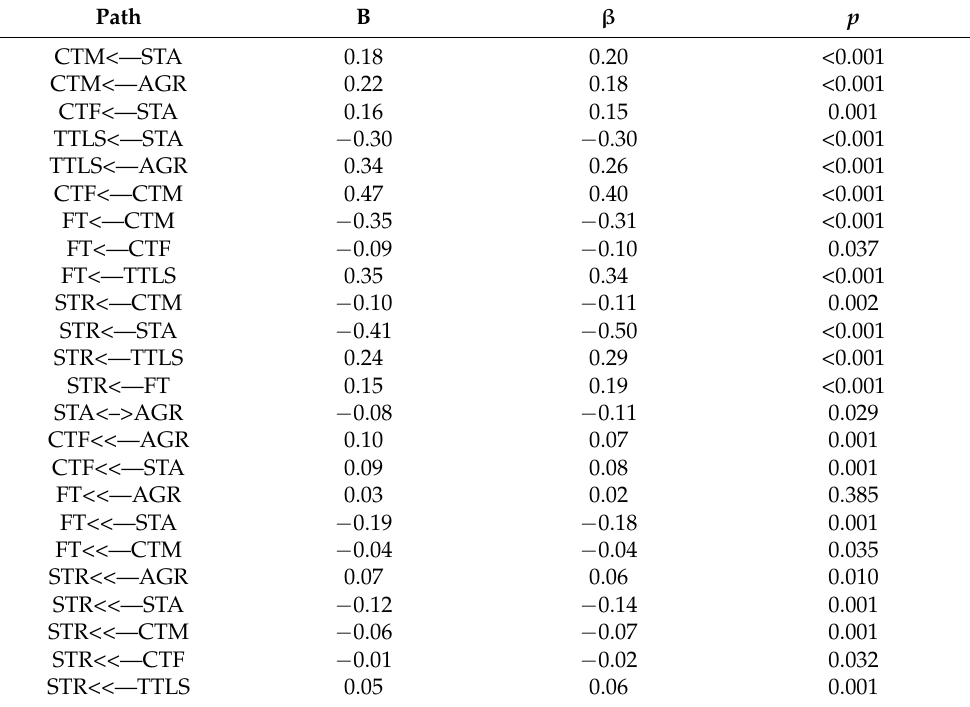
Table 4. Standardized and non-standardized path coefficients with their relevance: detailed direct and indirect effects.